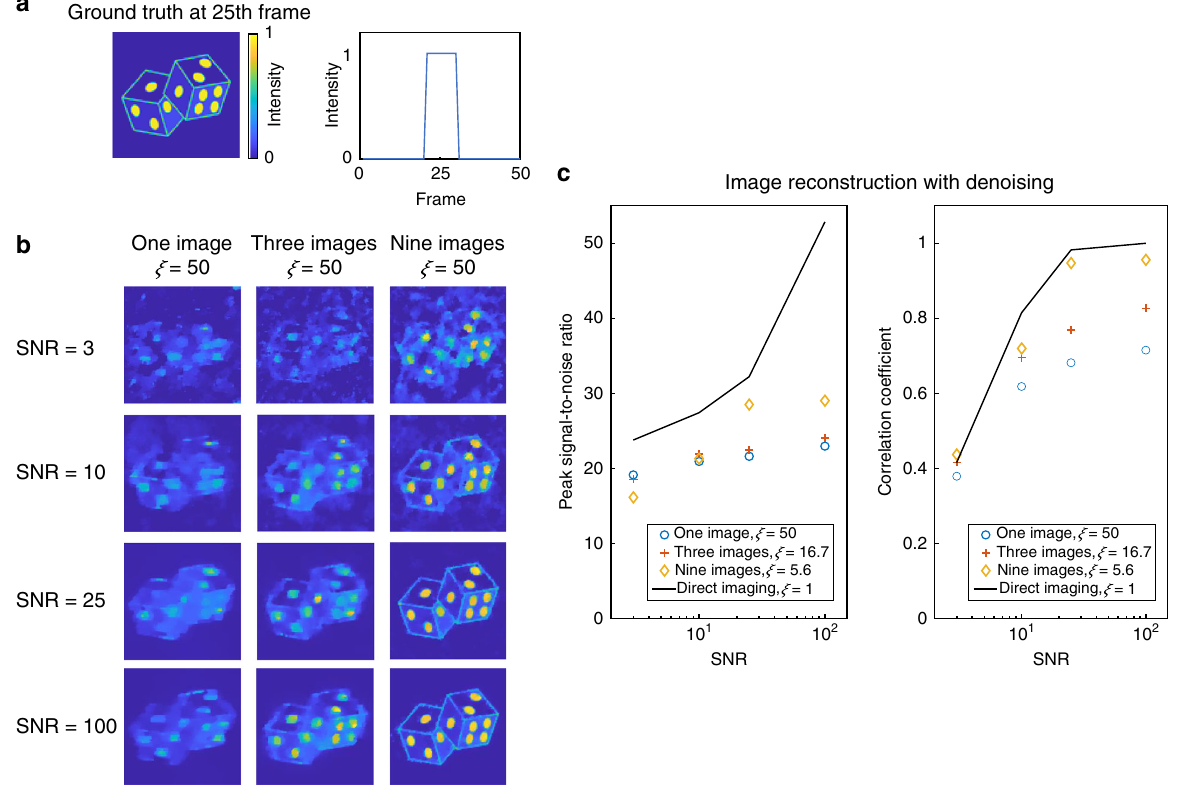
Fig. 9 Effect of the compression ratio on compressed sensing. a 3D datacube for the simulation. A total of 50 frames are compressed into a single frame. The 21st to 30th frames contain the image of the dice, and the rest 40 frames are blank. b Reconstructed 3D datacube. The 25th frames at given compression ratios and signal to noise ratios are shown. c Peak signal-to-noise ratio and correlation coef fi cient of the reconstructed datacube given the noise-free solution in ( a